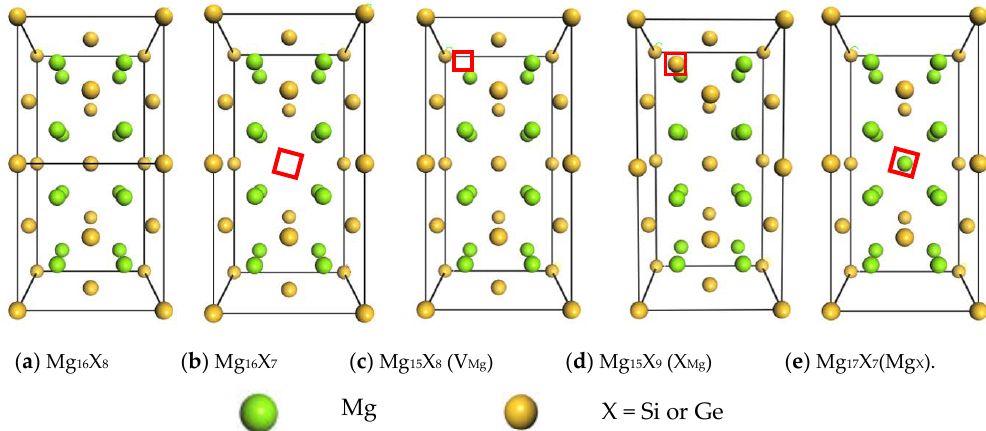
Figure 1. 1 × 1 × 2 supercell crystal structure of Mg 2 X (X = Si, Ge) with vacancy point defects or anti-site defects, (a) Mg 16 X 8 , (b) Mg 16 X 7 (V X ), (c) Mg 15 X 8 (V Mg ), (d) Mg 15 X 9 (X Mg ), and (e) Mg 17 X 7 (Mg X ). The red squares represent the position of the vacancy or anti-site defects.